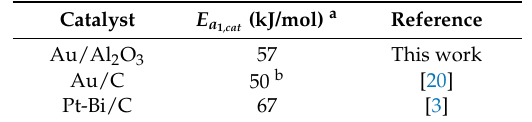
value and those reported in the 1, cat